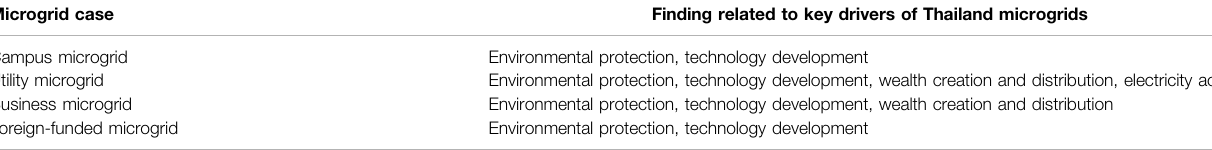
TABLE 2 | Findings related to key drivers of Thailand microgrids. Microgrid